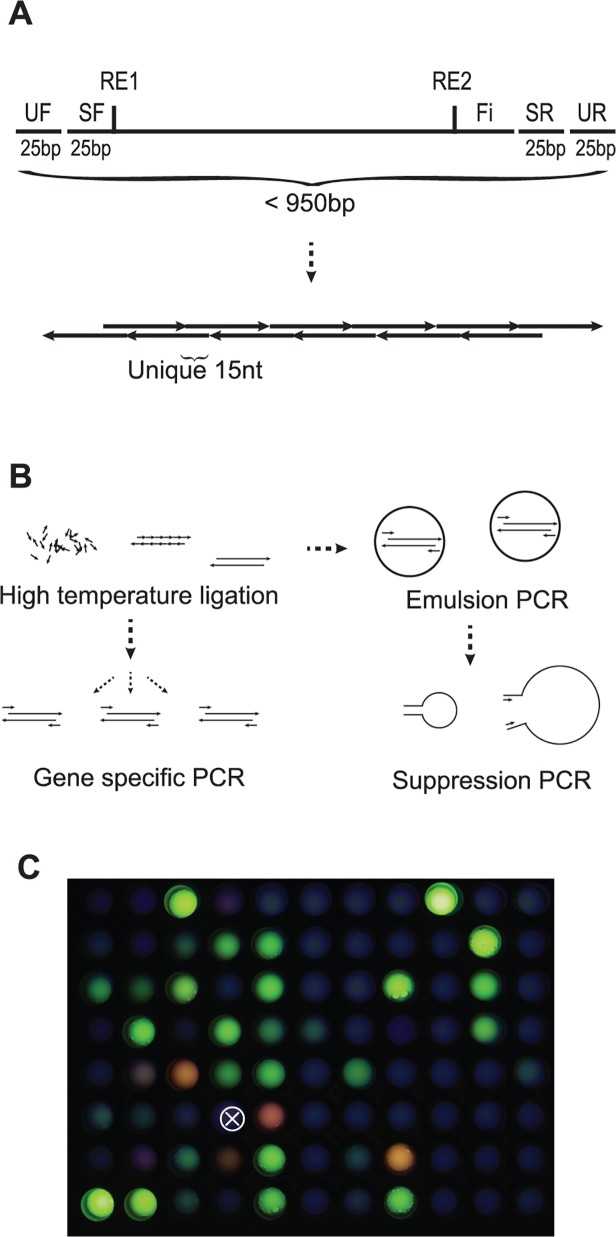
Multiplex Library Synthesis of Genes.(A) Individual genes (top) are assembled from a set of oligonucleotides (arrows) with 15 bp of unique overlapping sequence. Synthons include universal forward (UF) and reverse (UR) primer binding regions common for all genes in the library, and specific forward (SF) and reverse (SR) sites for amplification of individual genes. Synthons include restriction endonuclease sites (RE1 = EcoRI, RE2 = BamHI) for downstream cloning purposes, a random filler sequence (Fi) for length standardization, and are < 950 bp long. (B) Gene synthesis from a pooled library of oligonucleotide starts with high temperature annealing and ligation, then individual genes can either be amplified with SF/SR primers (left) or library of genes is synthesized and amplified (right) with emulsion PCR using UF/UR primers with annealing 5’ and 3’ overhangs to enable suppression PCR, which preferentially amplifies longer synthons. (C) Excitation of 87 GFP variants successfully synthesized, amplified individually, then expressed in E. coli show functional fluorescent protein at various emission wavelengths. Images are combined from ultraviolet (top layer, 50% transparency) and blue light illumination (470nm) with no emission filtering. White X represents the negative control well with media only.